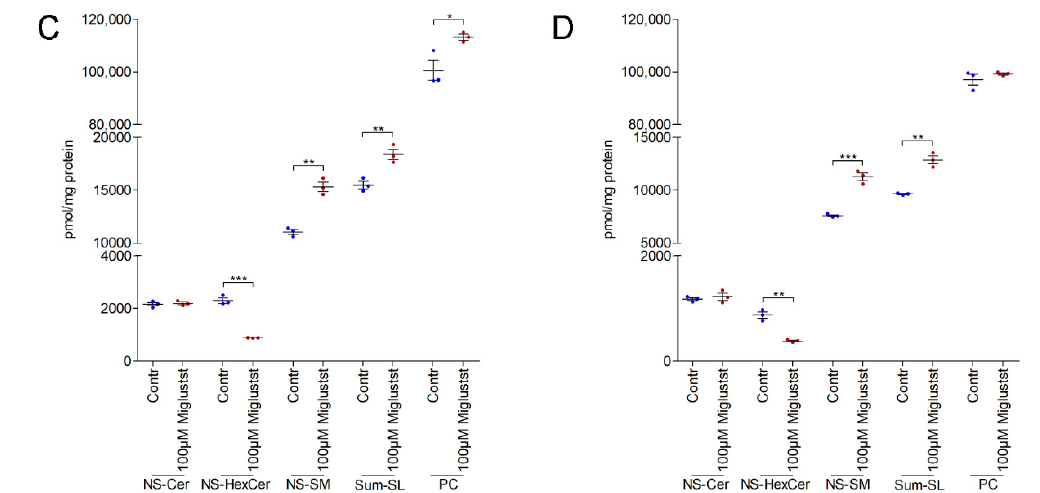
Figure 6. Genz treatment of Lovo and HCT116 cells lead to a concentration-dependent increase of sphingomyelin (SM). Lipids were quantified by C18-reversed phase UPLC/MS 2 in MRM mode using internal standards for each lipid class. Major sphingolipids containing non-hydroxy fatty acids (N) and (C18)-sphingosine (S) were recorded; Cer, ceramide, HexCer: hexosylceramide, SM, sphingomyelin, and PC: phosphatidylcholine. ( A , B ) HexCer was reduced to a similar extent in Genz- or UGCG -gRNA-treated Lovo ( A ) or HCT116 cells ( B ). The SM content in Lovo ( A ) and HCT116 ( B ) cells was remarkably elevated upon Genz treatment and much higher as in cells treated with UGCG -gRNA in which the SM-increase correlated vice versa with the reduction of GSLs. The ceramide levels in Lovo and HCT116 cells upon Genz treatment were similar as in controls. ( C , D ) SM levels in Miglustat-treated Lovo ( C ) and HCT116 cells ( D ) were also elevated as compared to controls. Ceramides appeared unaltered upon Miglustat treatment; each data point on the graphs represents one biological replicate; significances are *, p ≤ 0.05; **, p < 0.01; ***, p < 0.001. Int. J. Mol. Sci. 2021 , 22 , x FOR PEER REVIEW